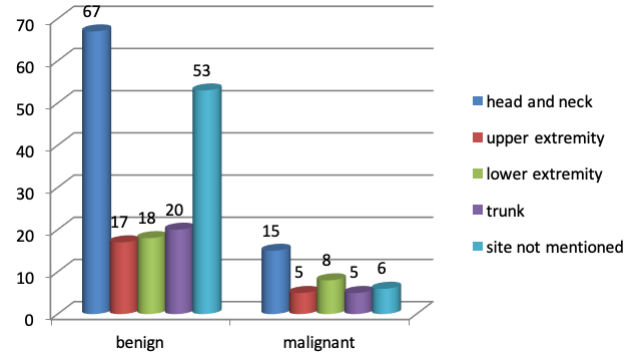
Figure 5: Anatomical site-wise distribution of skin